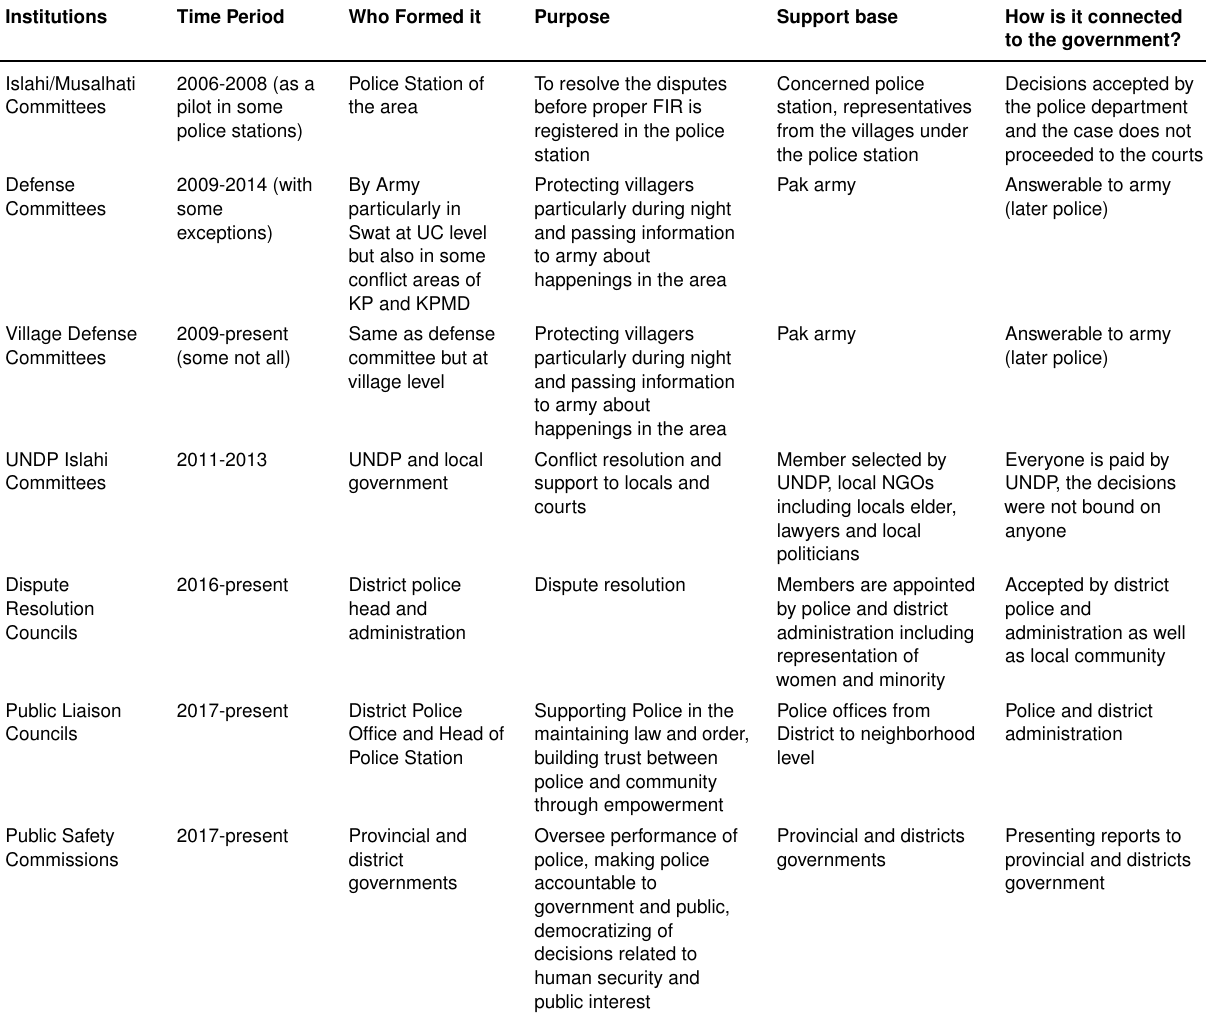
Table 2. Integrated (‘hybrid’) Government and Civil Society